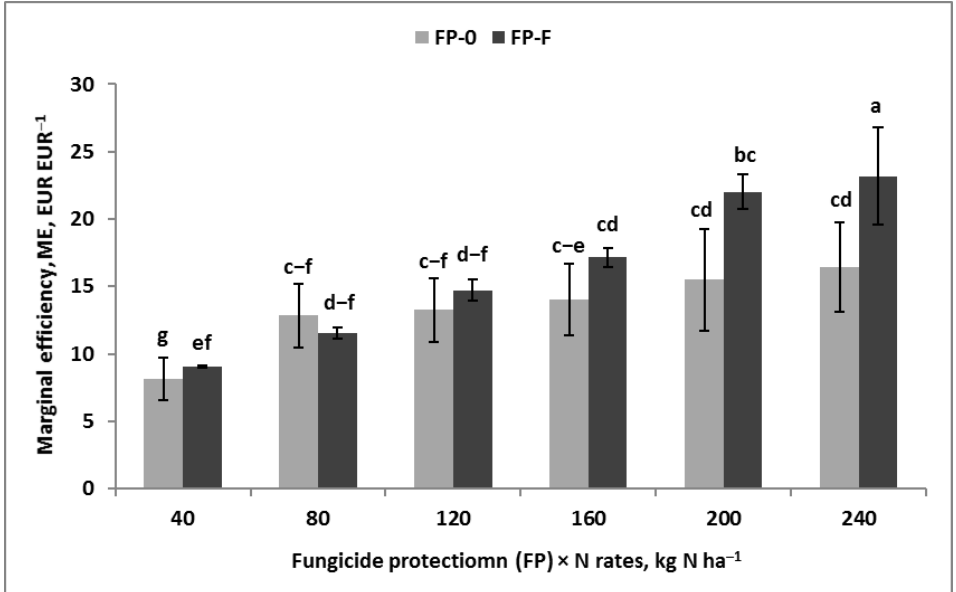
Figure 6. Effect of winter wheat protection with fungicides and rates of fertiliser nitrogen on marginal efficiency of grain production. Similar letters in the column means a lack of significant differences using Tukey’s test; the vertical bar in the column refers to the standard error of the mean. On the site without fungicide protection, the maximum ME was 26.3 EUR per 1.0